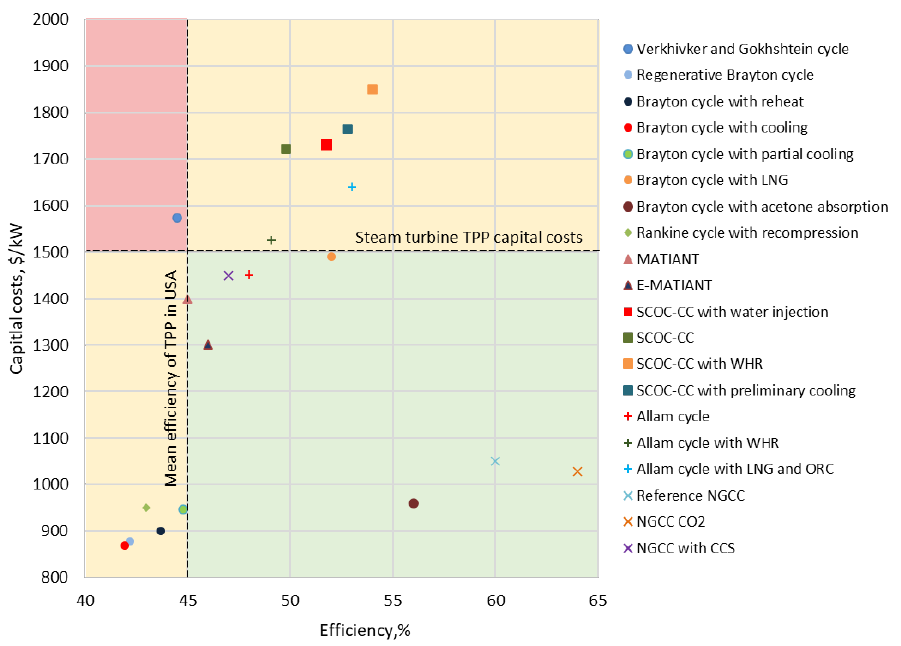
Figure 28. High-capacity energy CO 2 power cycles technologies in comparison with the current average level and level of the best available technologies.